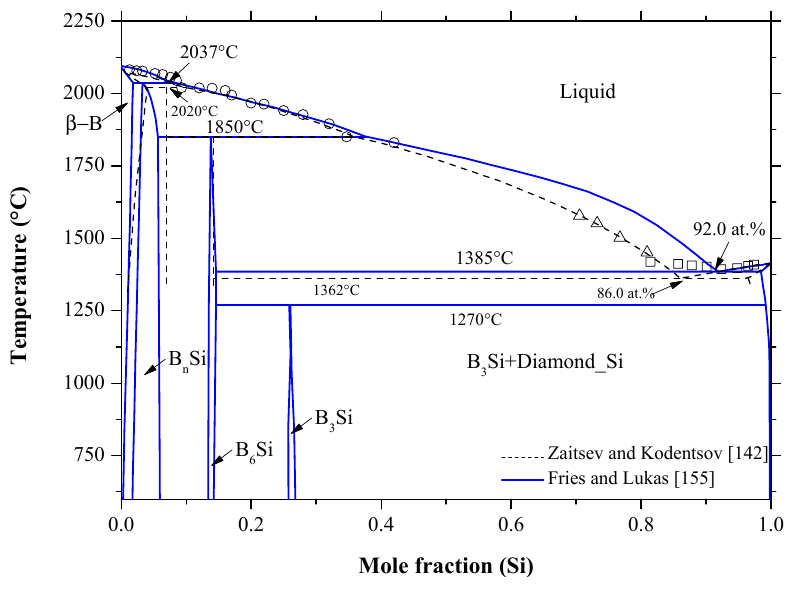
Figure 10. The B-Si phase diagram redrawn after [155]; ----: [142]; □ : [144]; ○ : [147]; Δ : [142]. The B solubility in Si data is scattered and contradictory. The solid solubility of boron in silicon as a function of temperature was first presented by Vick and Whittle [153]. According to these authors, the solid solubility varies from 9.0 × 10 − 4 at % at 700 °C to 1.4 × 10 − 2 at % at 1151 °C. Olesinski and Abbaschian [139], using different sources [114,141,142], estimated the B solubility in Si to be ~3.0 at %. Whereas, Zaitsev and Kodentsov [138] reported maximum solubility of 3.5 at % B at 1362 °C, favoring the results of Samsonov and Sleptsov [141] only. Although, the calculated solubility of B in Si by Fries and Lukas [151] is in good agreement with the data of [144,153] at 1.6 at %, further investigation of this region is highly recommended. Since the results of Armas et al. [143] and Vick and Whittle [152] support one another, a solvus line consistent with them is adopted in this work.